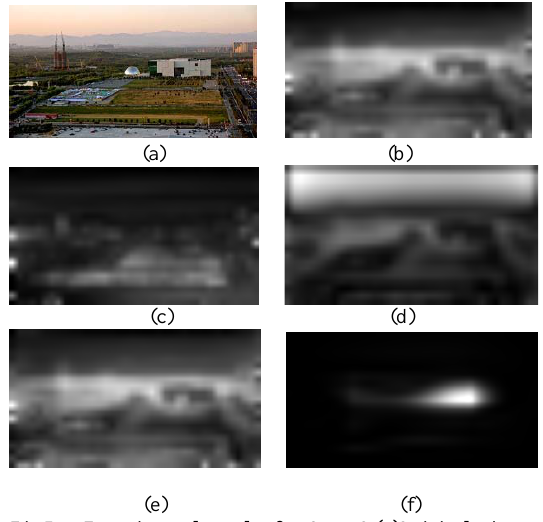
Experimental results for Case 2.(a)Original picture; (b) Intensity feature map;(c) Color feature map; (d) optimization ;(f) Saliency map with